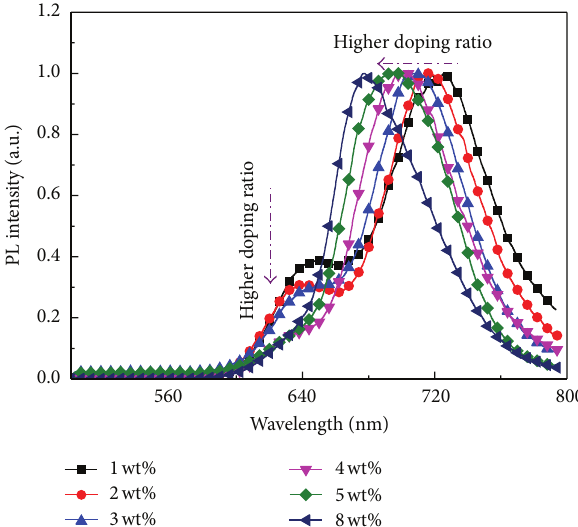
Figure 4: PL spectra of P3HT:Ir(btpy) 3 films with different doping ratio under the excitation of 410 nm light.